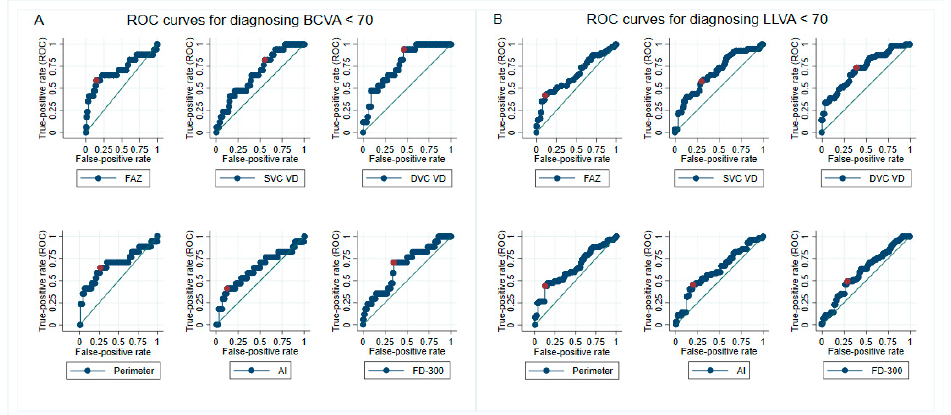
Figure 3. Receiver operating characteristic (ROC) curves of different parameters in identifying mild visual impairment. The cutoff point (marked as a red-filled circle) was defined as the threshold having the largest sum of sensitivity and specificity in determining visual impairment in daylight ( A ) or dim light ( B ). Special attention can be drawn to the 41.9% whole image deep vascular complex vessel density (DVC VD) (Top row, third from the left), which had the best discriminatory ability to diagnose patients with best-corrected visual acuity (BCVA) < 70 Early Treatment Diabetic Retinopathy Study (ETDRS) letters (area under the curve = 0.77, sensitivity 94%, specificity 54%, likelihood ratio = 2.04). Abbreviations: AI = acircularity index; BCVA = best-corrected visual acuity; DVC = deep vascular complex; FAZ = foveal avascular zone; FD–300 = parafoveal 300- µ m ring vessel density; LLVA = low- luminance visual acuity; ROC = receiver operating characteristic; SVC = superficial vascular complex;